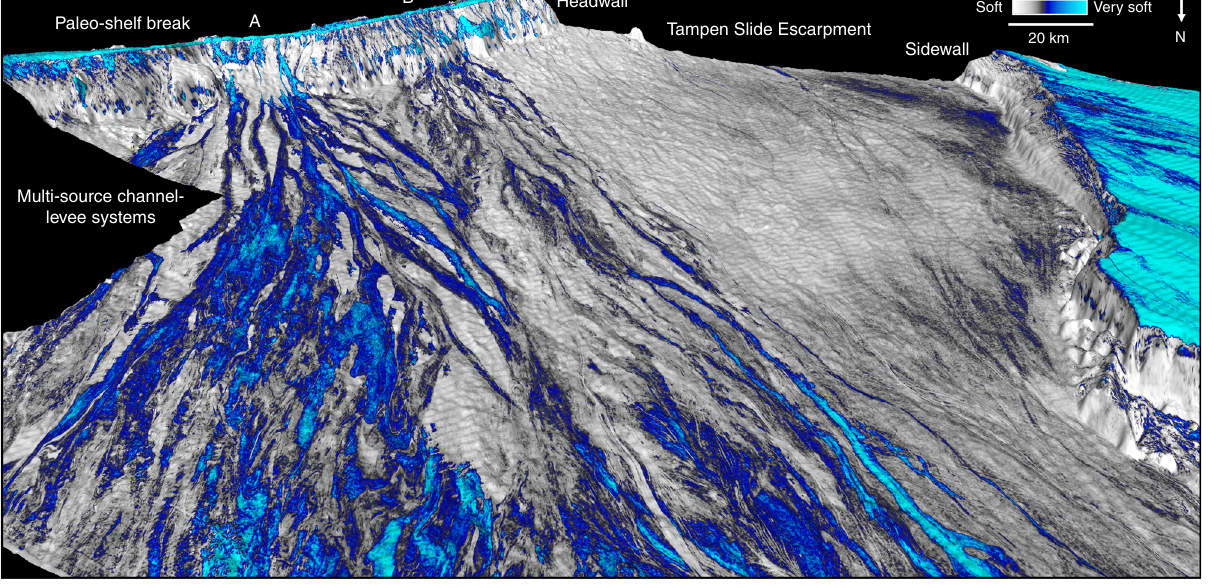
Fig. 6 North Sea Fan at the beginning of the last glaciation. 3D view of the Horizon Base MIS 2 (Fig. 2) draped by the minimum amplitude extraction in a window of 30 ms. The very soft bands (blue) are interpreted as channels of seismically distinct turbidite fl ows at the initiation of the last shelf-edge glaciation ( t = 23 kyr). The Norwegian Channel Ice Stream, located at the shelf edge, forms two sediment sources at that time (indicated by A and B), from where meltwater turbidites fi ll the escarpment shaped by the Tampen